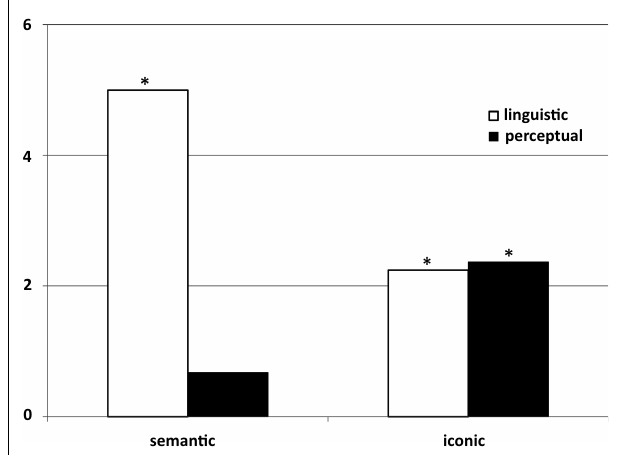
FIGURE 1 | Strength of the mixed effects regressions on the RTs in absolute t -values for each of the two conditions for linguistic (order frequency) and perceptual (iconicity ratings) factors. Asterisks mark significant strengths (p < 0.05) of relationship with